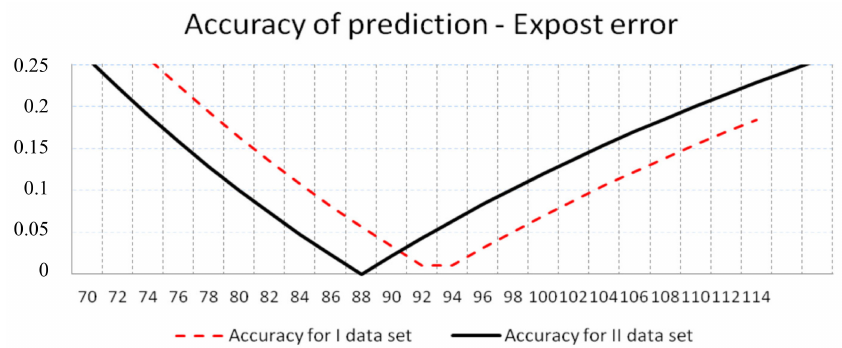
Figure 4. Accuracy of prediction of failure-free time obtained using the empirical moments approach.